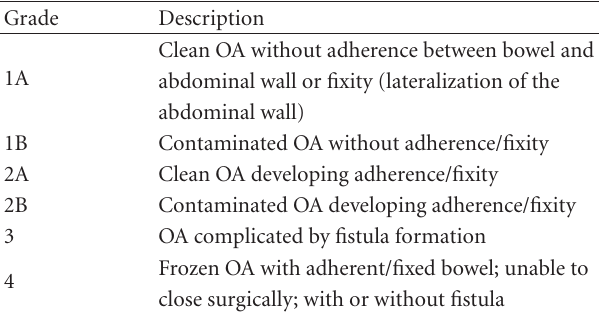
Table 4: Proposed classification of the open abdomen. Adapted from Bj¨orck et al.